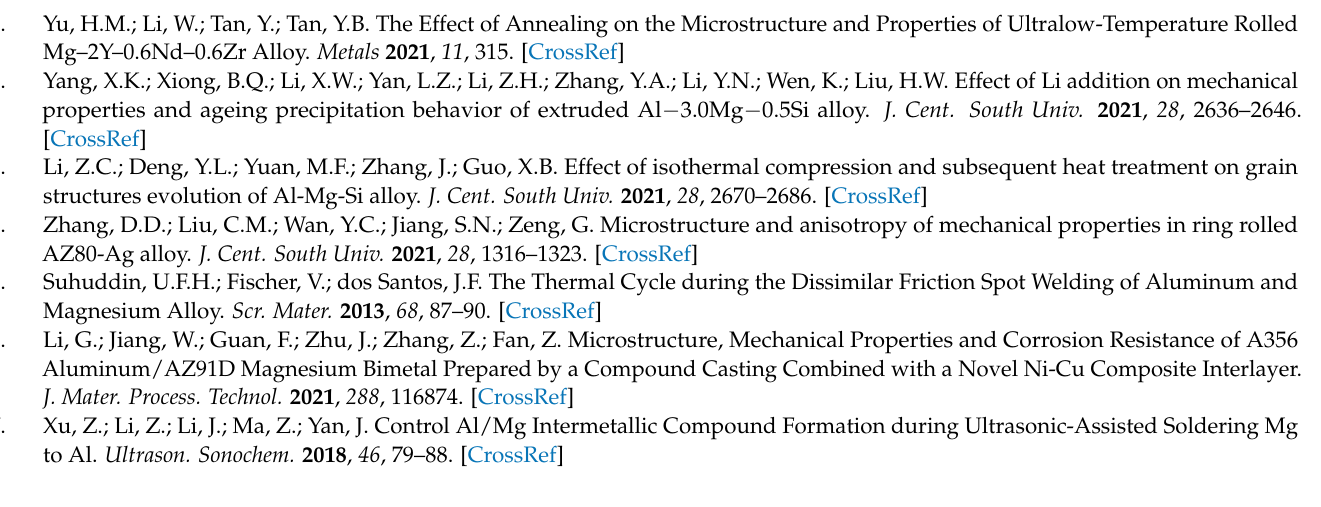
standard for the measurement., Figure S3: The processed image used for measurement., Figure S4: Space calibration, Figure S5: Select the area to be measured., Figure S6: Using the “perform segmenta- tion” function to convert images to black and white image., Figure S7: The black and white image, Figure S8: Click on the “Count and measure objects” option, Figure S9: Click on the “Select Measure- ments” option., Figure S10: Setup the measurement options., Figure S11: Measurement